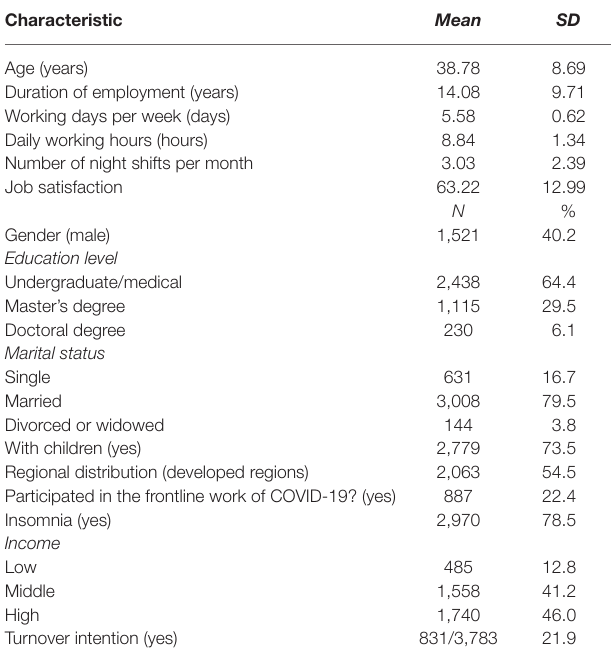
TABLE 1 | Basic characteristics of psychiatrists in the final sample ( N =